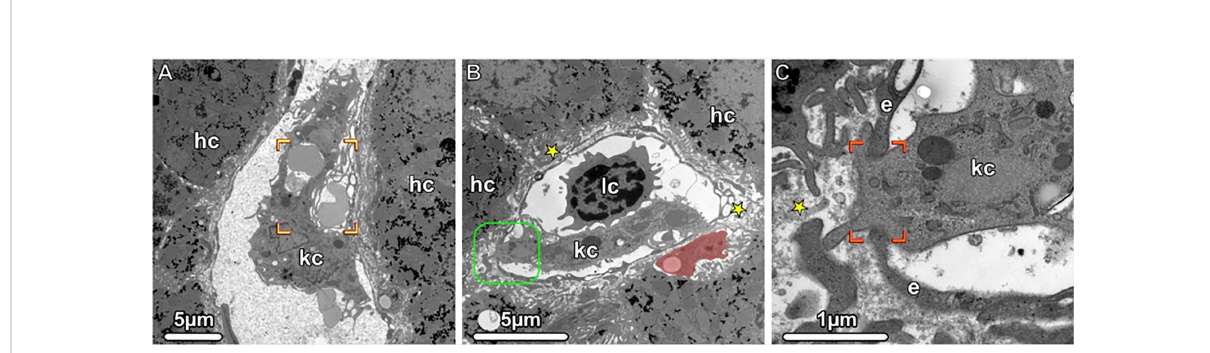
FIGURE 4 Kupffer Cells, Transmission electron microscopy (TEM). (A, B) Liver sinusoids with Kupffer cells (kc), lymphocytes (lc) and erythrocytes are shown. The damaged erythrocytes (brackets) are phagocytosed by a Kupffer cell, and in the Disse space (asterisks), an ito cell (highlighted in light red) is visible storing lipid droplets. The boxed area is shown in higher magni fi cation in (C) . A portion of the Kupffer cell (kc) penetrates the fenestrated endothelium (e and brackets), thus gaining accesses to the Disse space (asterisks). hc,